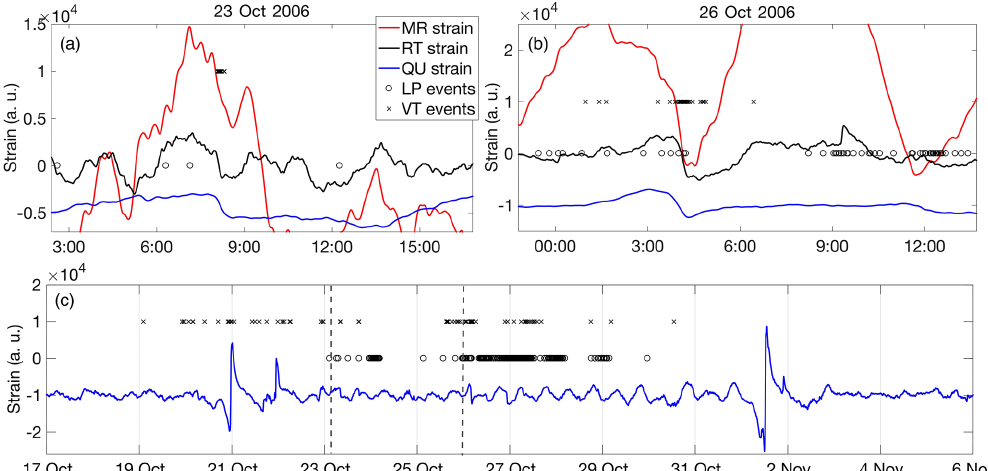
Figure 5. QU strainmeter data recorded during the period 17 October–6 November 2006. Raw data have been corrected by removing earth tides and the effects of atmospheric pressure variations before applying a band-pass filter in the 0.0005–0.005Hz frequency band. The units of strain are dimensionless, relative to an arbitrary datum. (c) shows the overall strain in the period: crosses and circles show VT and LP events, respectively. (a) and (b) show a magnified comparison of strain transient recorded at the three sites (RT, MR and QU sites depicted in black, red and blue, respectively), corresponding to the two dashed lines depicted in (c)